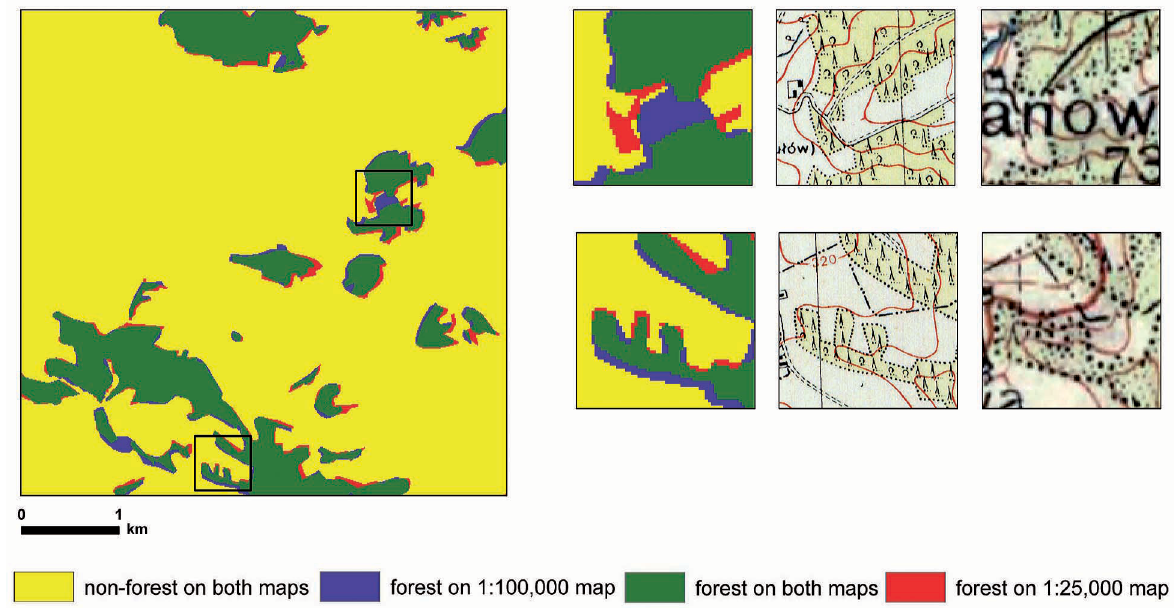
Fig. 2. Differences in forest distribution on the military maps in scale 1:100,000 and 1:25,000 in one of the test